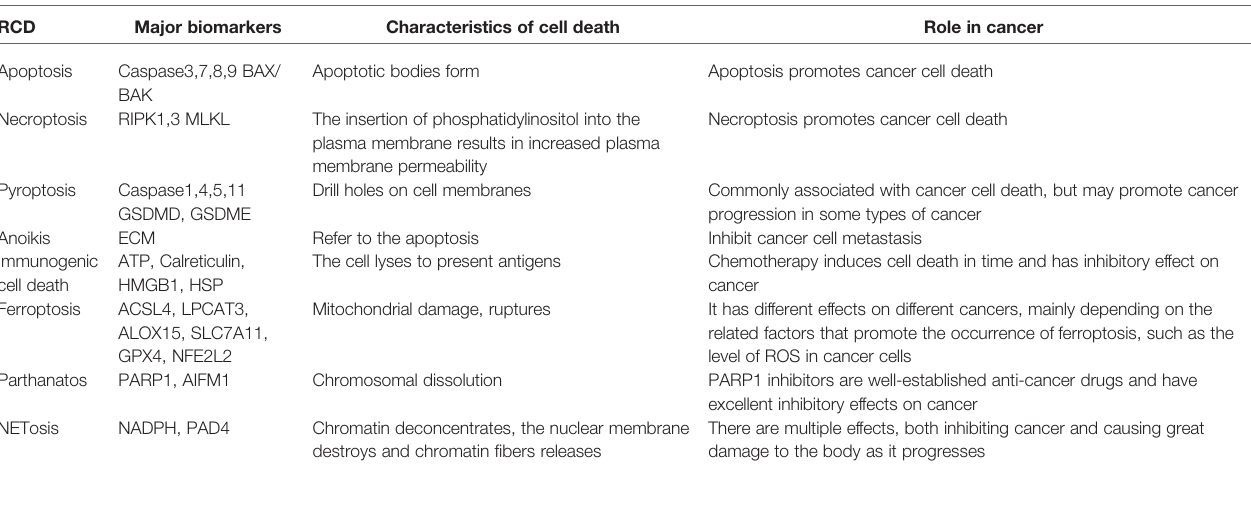
TABLE 3 | Differences between different types of